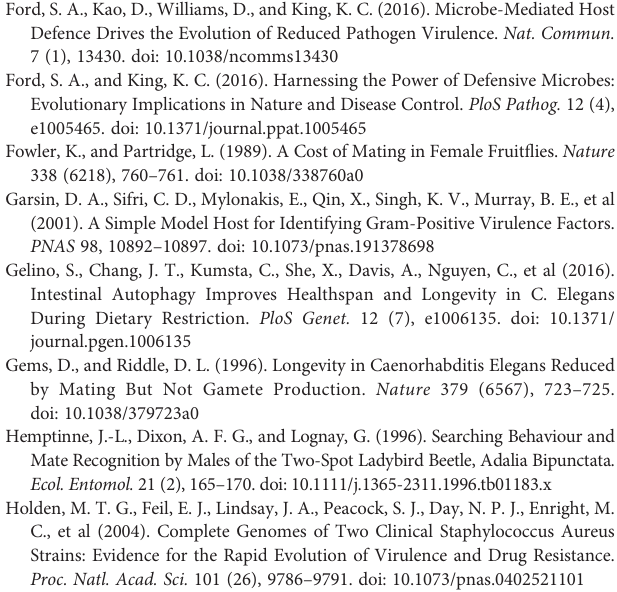
Supplementary Table 1 | Mating Treatments: Three different mating treatments (Unmated, Short-term mated and Lifetime mated) were set up for both sexes (Female in Red and Male in Blue), which were either single sex plates for each sex (Females only or Males only)or a 50:50 mixed population. Worms were lefton these mating plates for 6-8h, before three different mating treatments were set up (unmated, short-term mated, and lifetime mated, the darker the colour the longer the mating period) for each